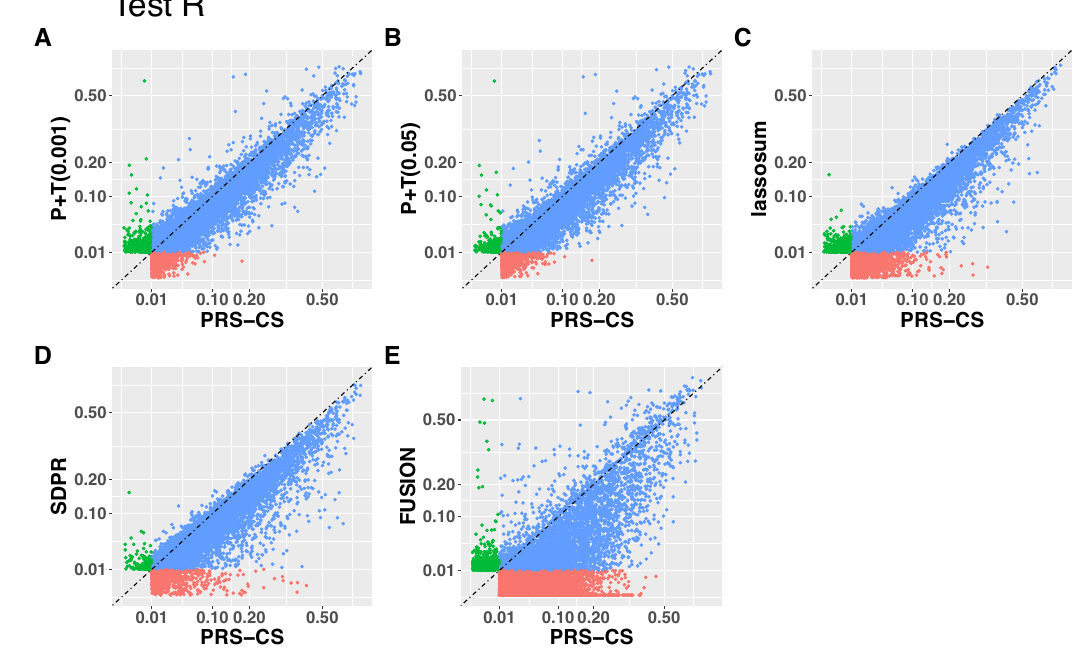
Fig. 3 | Test R 2 by PRS-CS versus P+T (0.001), P+T (0.05), lassosum, SDPR and FUSION. Test R 2 by PRS-CS versus P+T (0.001) ( A ), P+T (0.05) ( B ), lassosum ( C ), SDPR ( D ), and FUSION ( E ) with 315 GTEx V8 test samples, with different colors